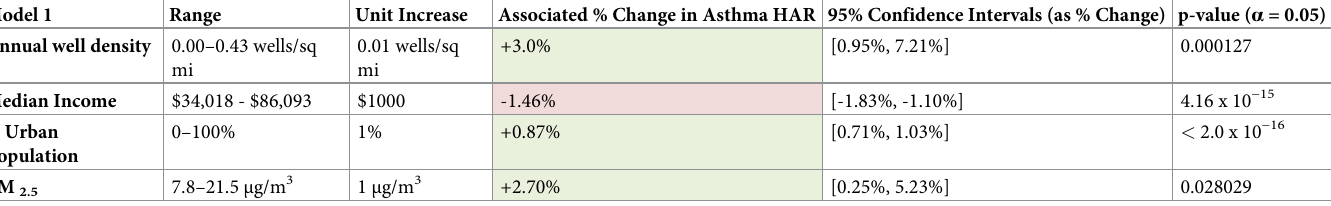
Table 2. Results of the multiple linear regression model using only rural counties to investigate the relationship between UNGD and asthma hospitalization. Model